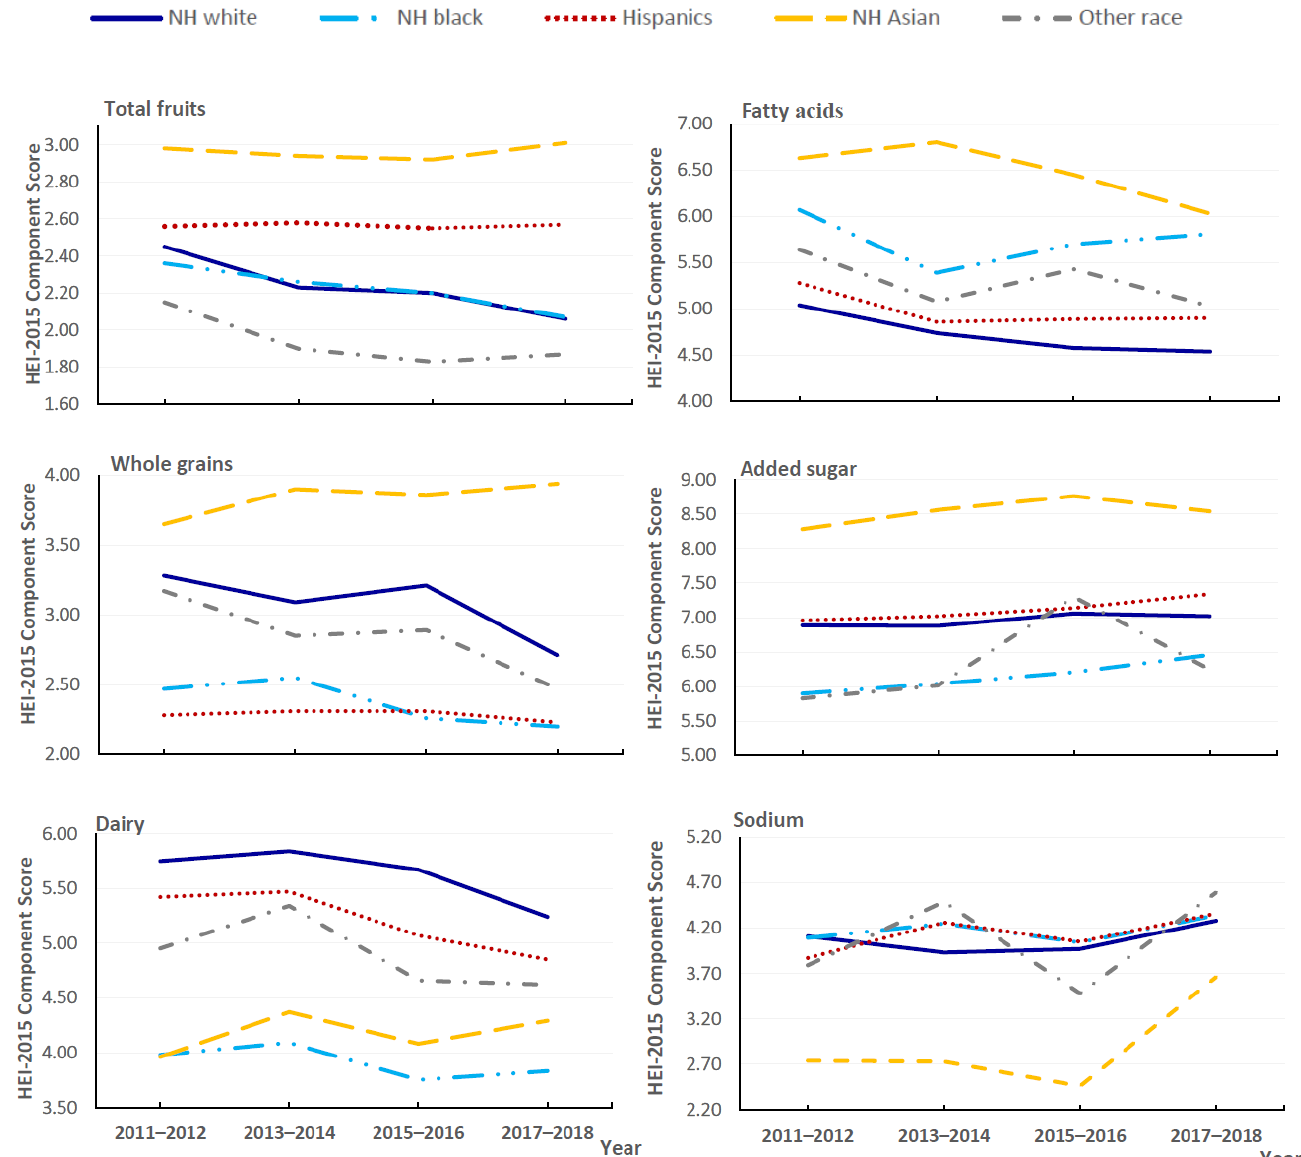
Figure 2. Trends in estimated scores of selected components of HEI-2015 by race/ethnicity among US adults aged ≥20 years for 2011 – 2018.